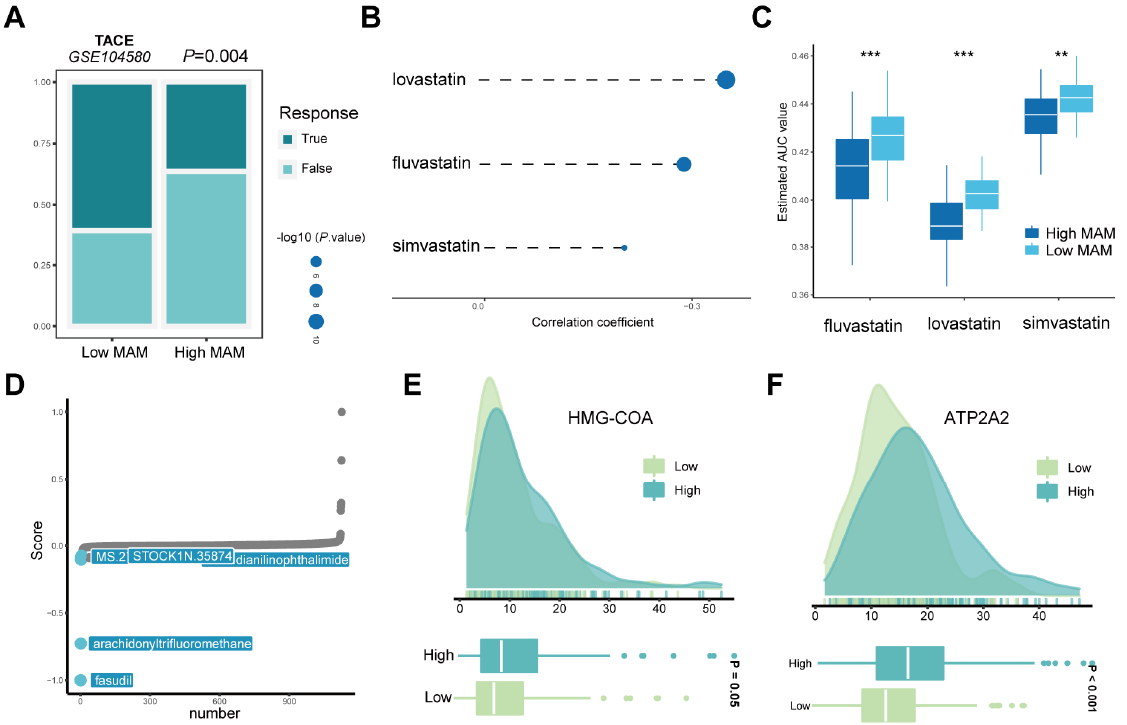
Figure 8. Differences in the response to chemotherapy between the high- and low-MAM-score groups. ( A ) Proportion of HCC patients with response to TACE therapy in the low- and high-MAM- score groups. ( B , C ): Spearman’s correlation analysis and differential drug response in the low- and high-MAM-score groups. ( D ): CMAP analysis of computational drug repositioning in the low- and high-MAM-score groups. ( E , F ): Ridge and box plots of HMG-COA and ATP2A2 in the low- and high-MAM-score groups. ** p ≤ 0.01; *** p ≤ 0.001.